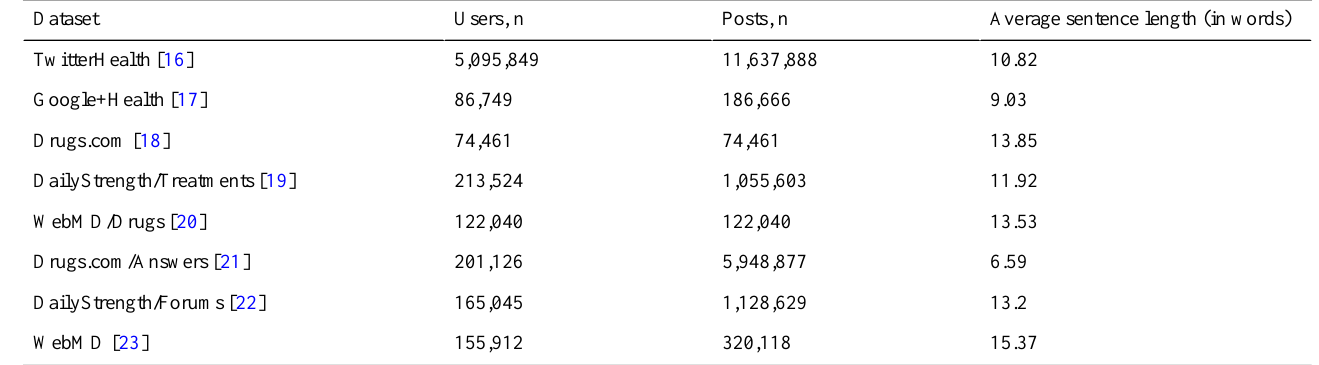
Table 1. Total number of users, posts, and average sentences length for each source.